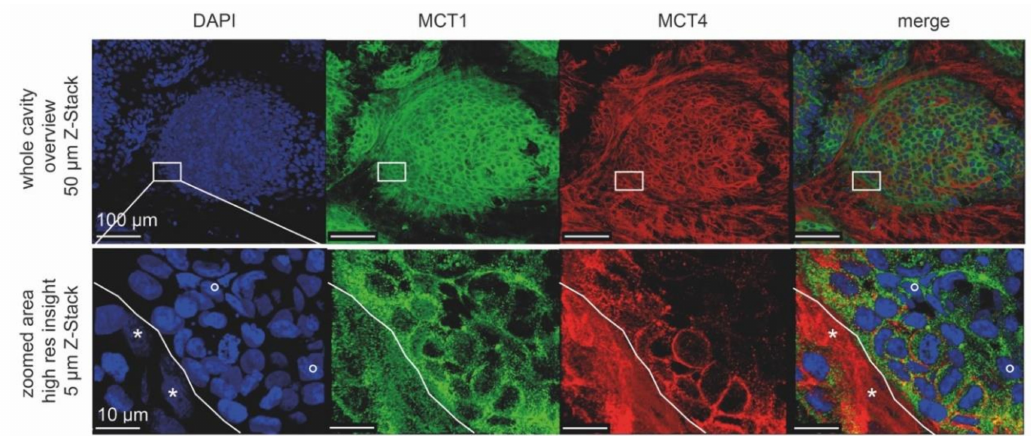
Figure 10. High-resolution confocal images reveal di ff erential cell-type-specific expression of lactate shuttle proteins upon co-cultivation of HT-29 and CCD-1137Sk cells. Per chip cavity, 2000 HT-29 and 2000 CCD-1137Sk cells were co-seeded. After four days, cultures were fixed, cleared, and then stained with DAPI as well as antibodies against MCT4 and MCT1 as markers for nuclei, lactate export, and lactate import, respectively. Subsequently, samples were imaged with confocal microscopy. Shown are representative maximum-z projections with the indicated thickness. Lower panels were taken from the same specimen region as boxed in the upper panels. White solid lines in the lower panels indicate the border between a zone primarily populated by CCD-1137Sk (lower left) and HT-29 cells (upper right). Asterisks and open circles point to typically dim and large nuclei of CCD-1137Sk vs. bright and small nuclei of HT-29